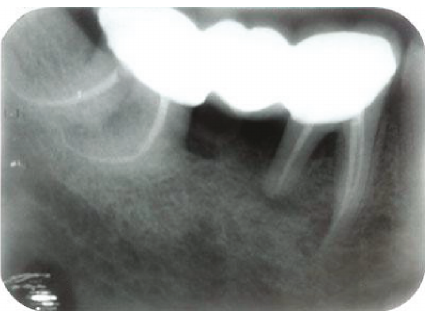
Figure 4: Radiograph showing fi nal